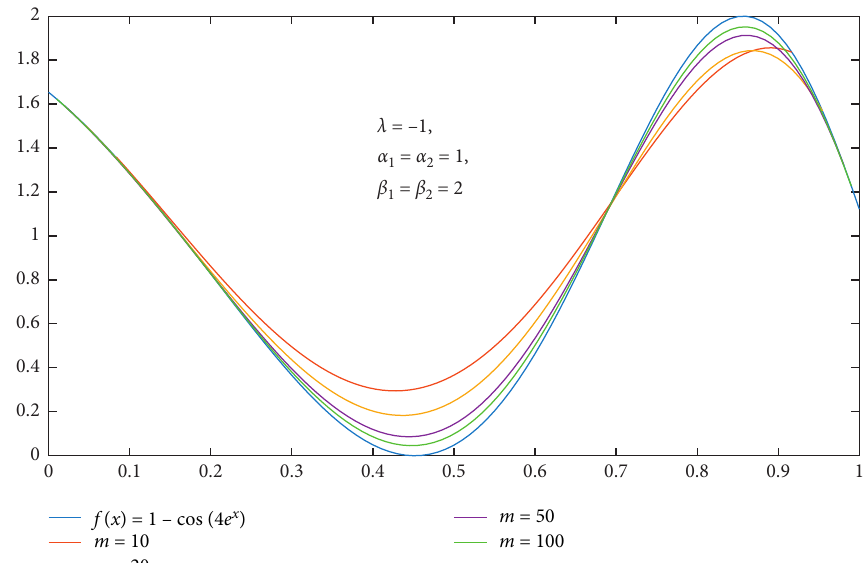
Figure 1: Convergence of G 1 , 2